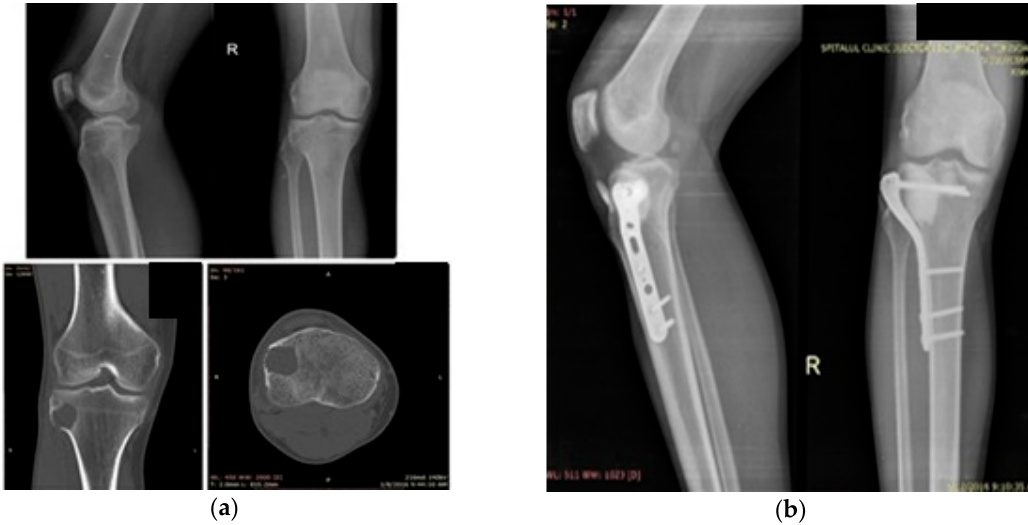
Figure 1. Case 1: 41-year-old male. ( a ) Giant cell tumor (GCT) of the proximal tibia, preoperative X-ray and CT scan; ( b ) X-ray (lateral and AP) two years after surgery with no signs of recurrence.